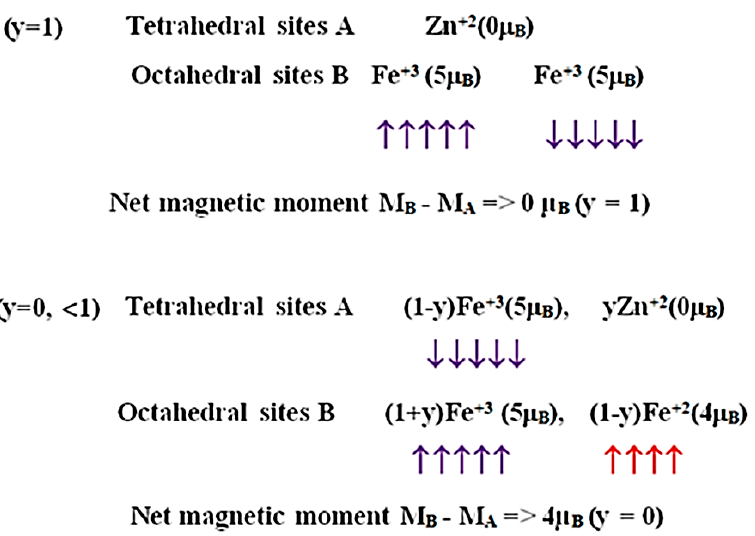
Figure 2. The spin magnetic moment per formula unit of Zn y Fe 3 − y O 4 for y = 0 and 1.